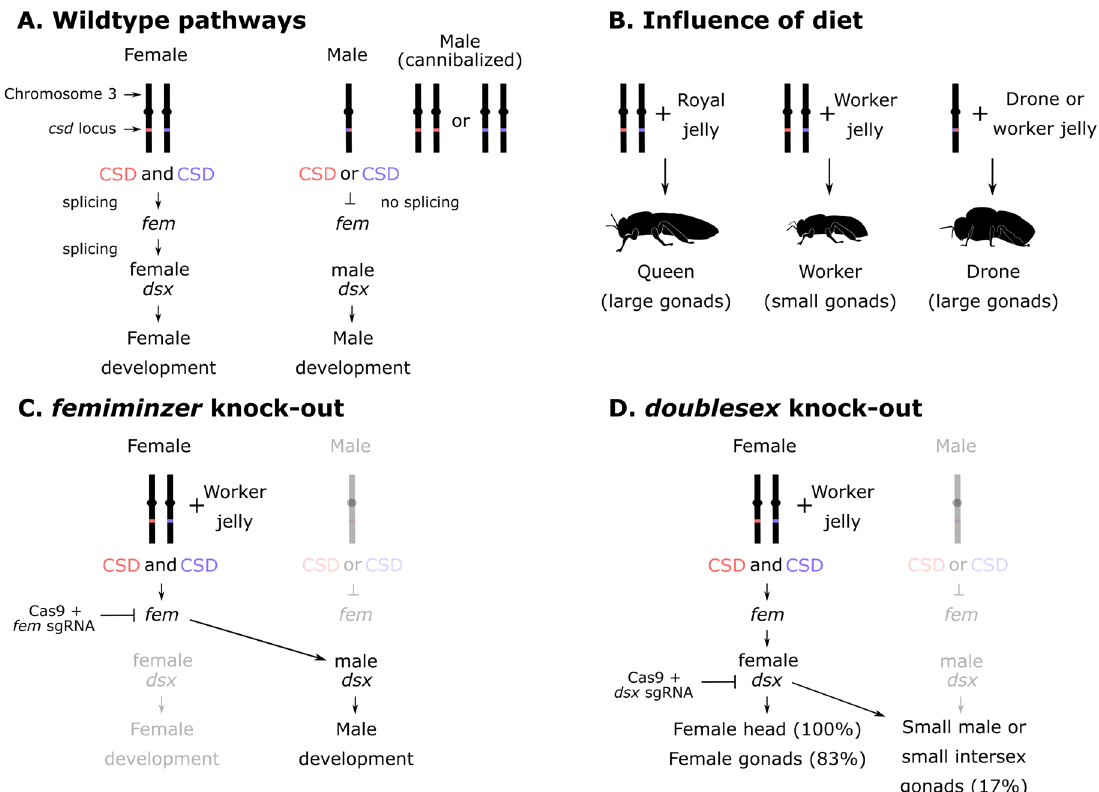
Fig 1. Sex and caste determination in honey bees. (A) Sex determination cascade. (B) General roles of diet in caste determination. Roth and colleagues demonstrated that drones develop normal, large gonads when reared on a worker diet. (C) The effect of fem and (D) dsx knock-out on sex determination and gonad size, as described by Roth and colleagues (2019). CRISPR, clustered regularly interspaced short palindromic repeats; CSD, complimentary sex determiner; dsx , doublesex; fem , feminizer; sgRNA, single guide